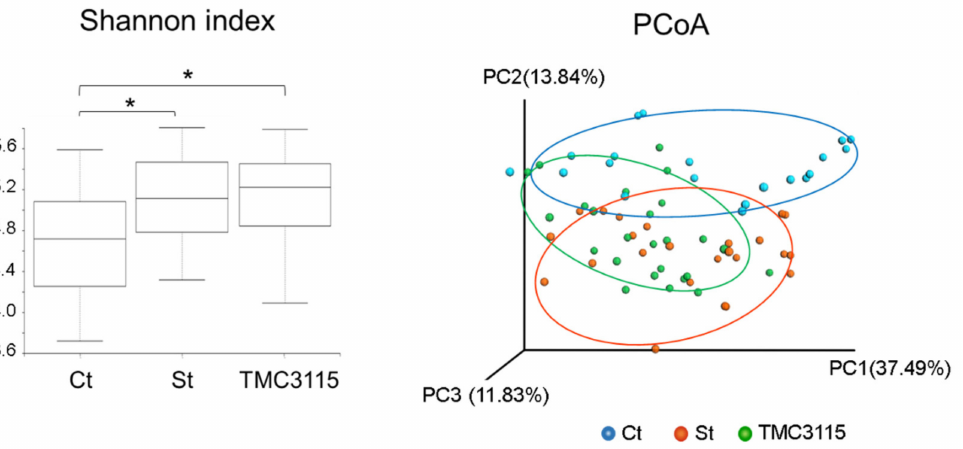
Figure 4. The α - and β -diversities of cecal microbiota. Ct: control mice, St: unsupplemented sCSDS mice, TMC3115: sCSDS mice supplemented with TMC3115. * indicates significant differences between groups, * p < 0.05.